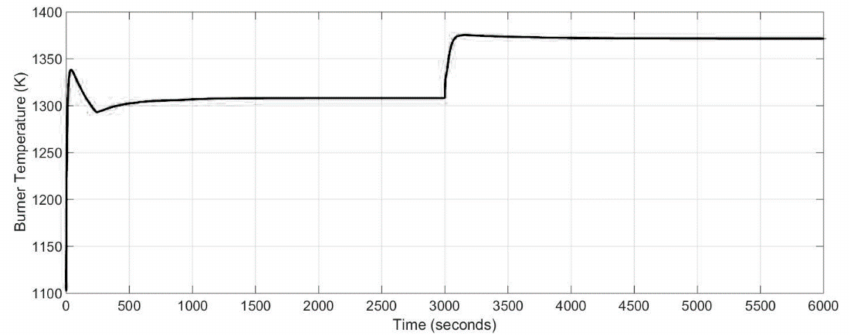
Figure 13. Dynamic response of the burner temperature for different stack drawn current